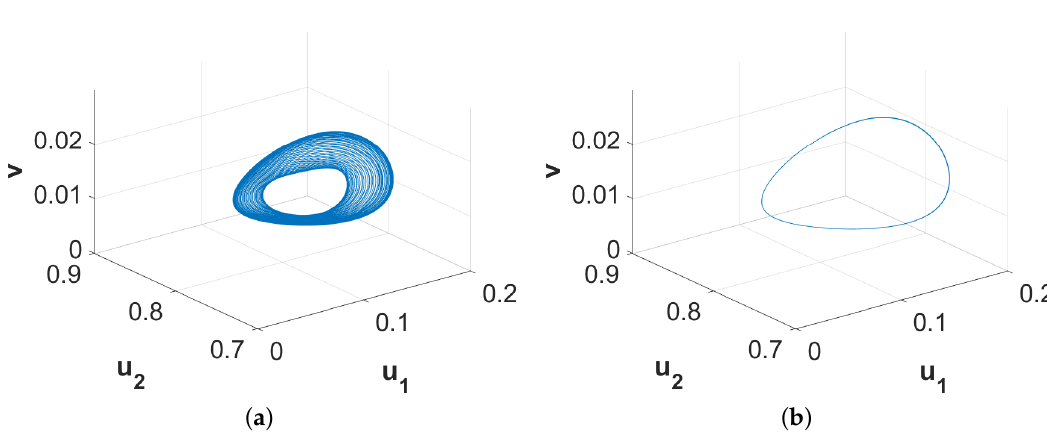
Figure 10. Phase diagrams of spatial average densities of the associated three species for (cid:101) = 8.0 and d 3 = 9.0 with ( a ) t ∈ [ 18,000,20, 000 ] , ( b ) t ∈ [ 58,000,60, 000 ] . Other parameter values are mentioned in